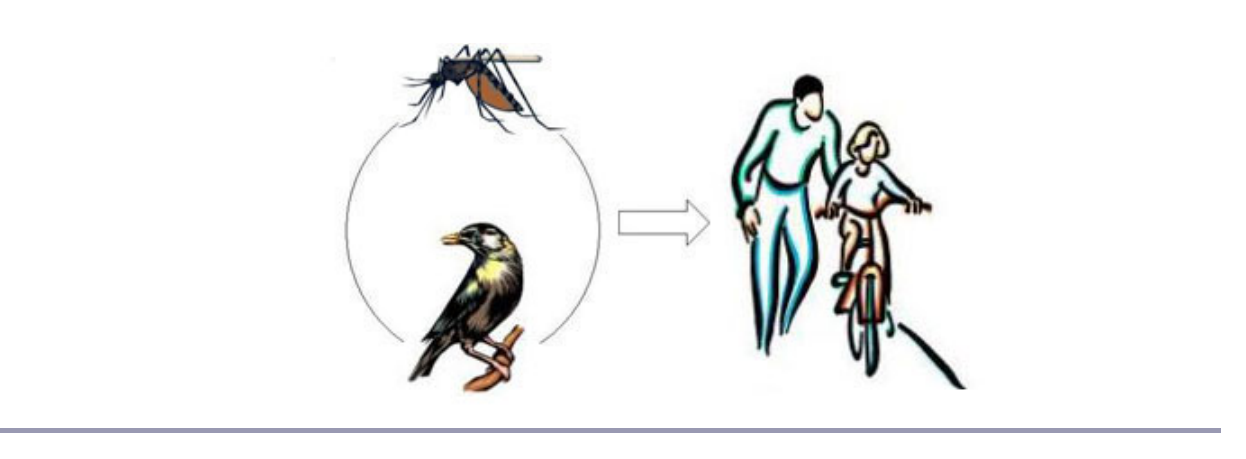
Fig. 1. The life cycle of the West Nile virus within vector (mosquito) and reservoir (mosquito, humans, and birds). Humans are viewed as a dead-end host in this